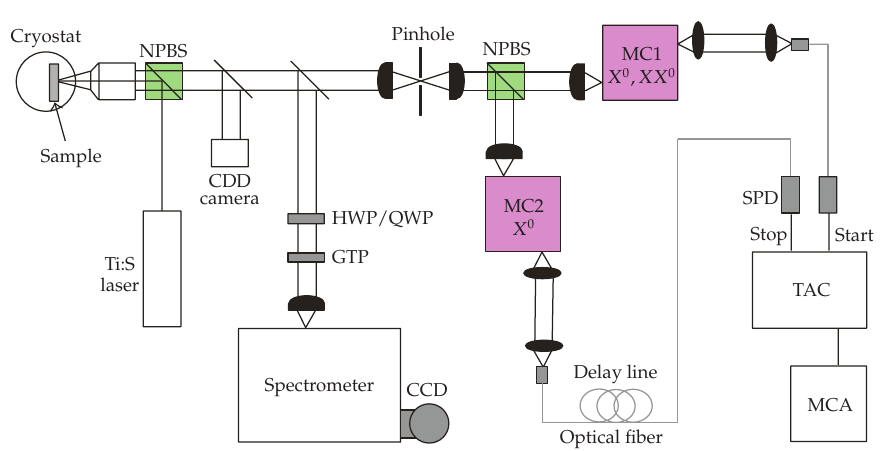
Figure 1: Overall experimental setup. CCD camera for imaging the sample surface, single/triple spectrometer equipped with CCD detector, and HBT setup for the second-order photon correlation measurements. Half wave plate (cid:5) HWP (cid:6) , quarter wave plate (cid:5) QWP (cid:6) , and Glan-Thomson polarizer (cid:5) GTP (cid:6) are used for polarization-dependent PL measurements. For photon correlation measurements, emitted photons are divided into two paths with non-polarized beam splitter (cid:5) NPBS (cid:6) and specific emission line is filtered by the monochromators (cid:5) MC1 and MC2 (cid:6) set in each optical paths. Photons are detected by